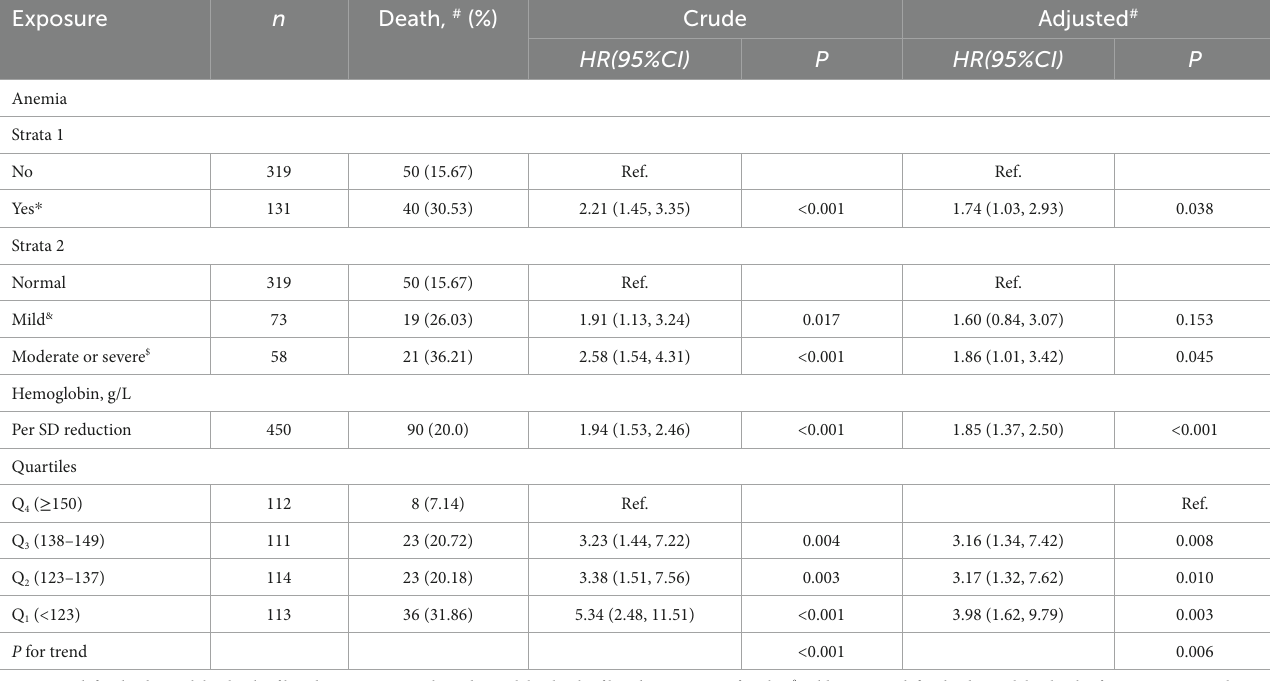
TABLE 2 Effect of anemia and hemoglobin on the mortality of PLWHA.